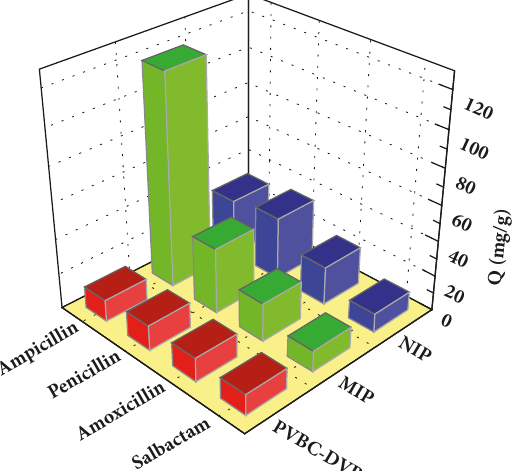
Figure 9: Selective adsorptions.